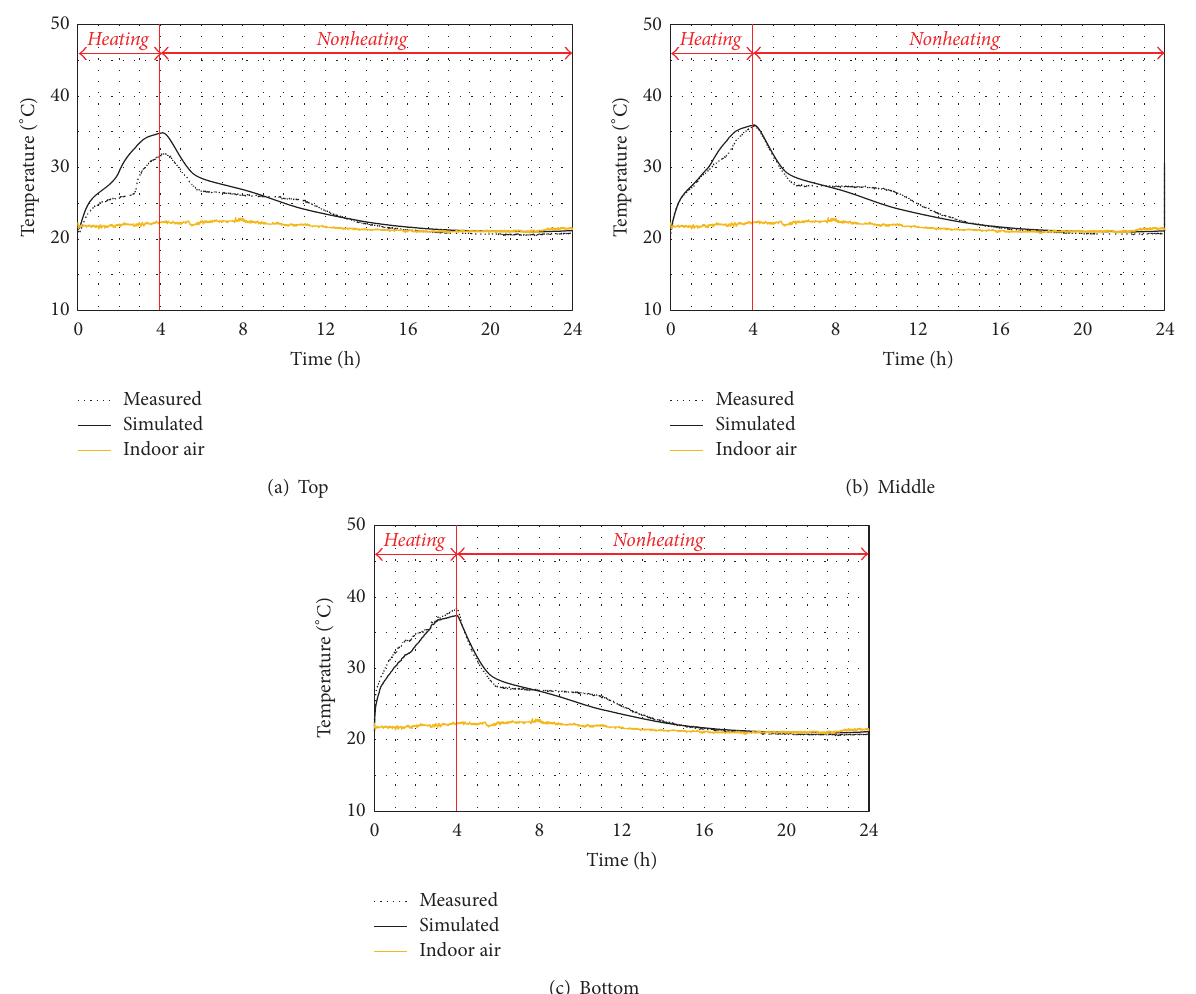
Figure 7: Temperature distributions of simulation and experimental values: concrete with